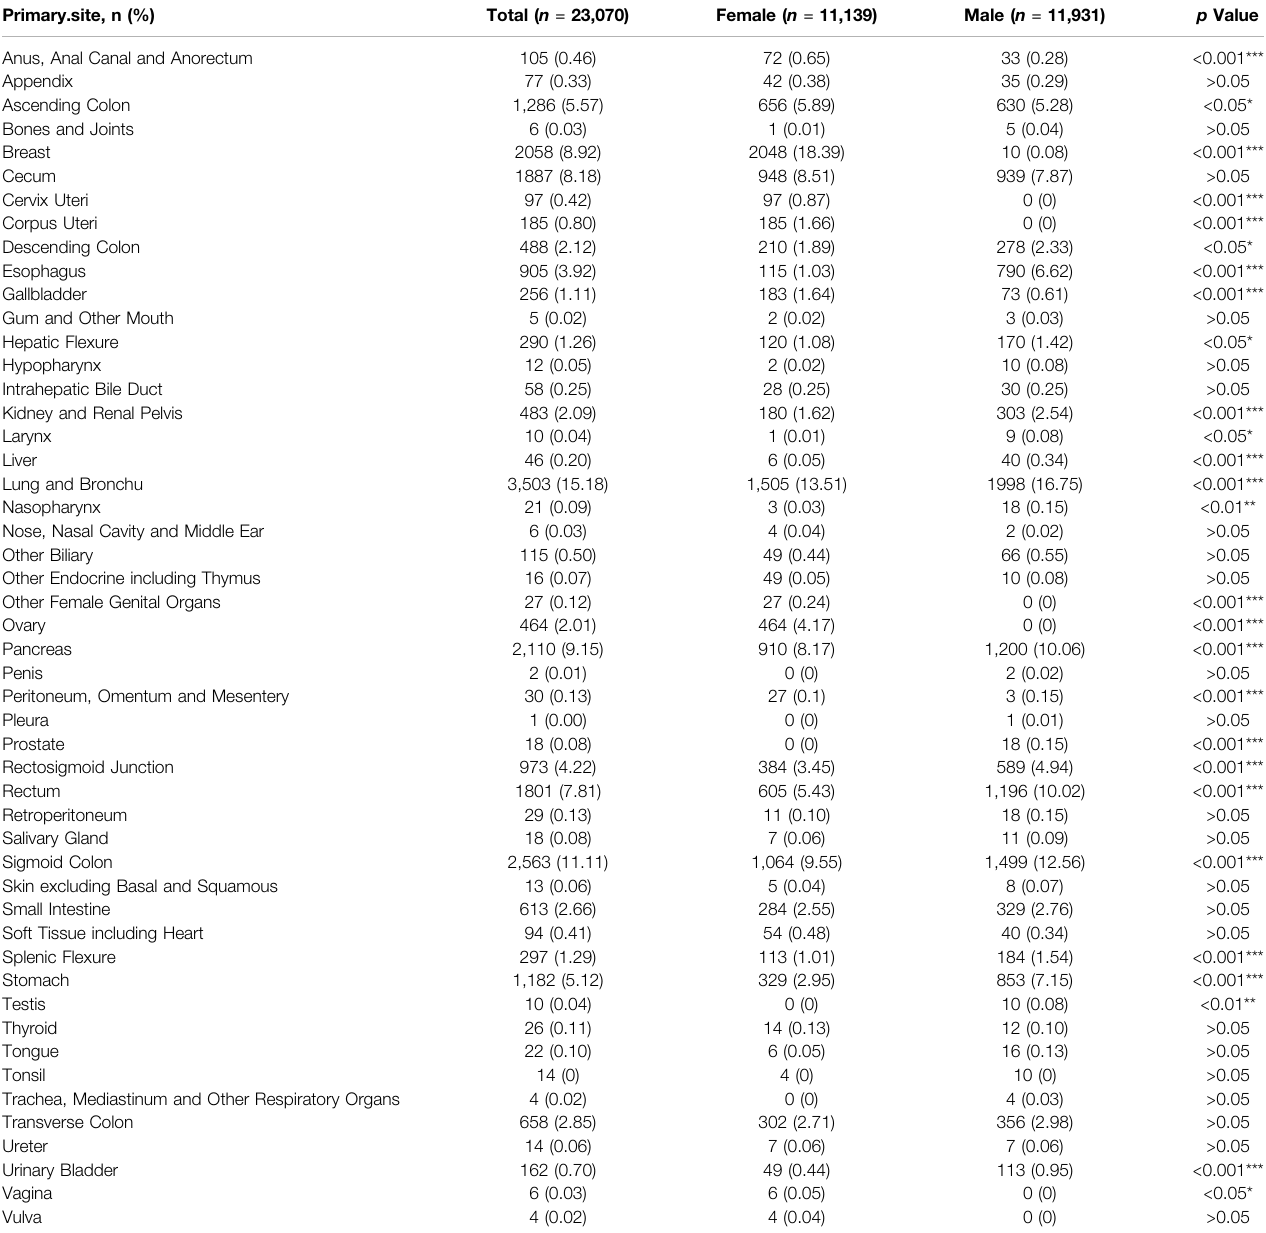
TABLE 1 | The frequency distribution of primary lesions of metastatic liver